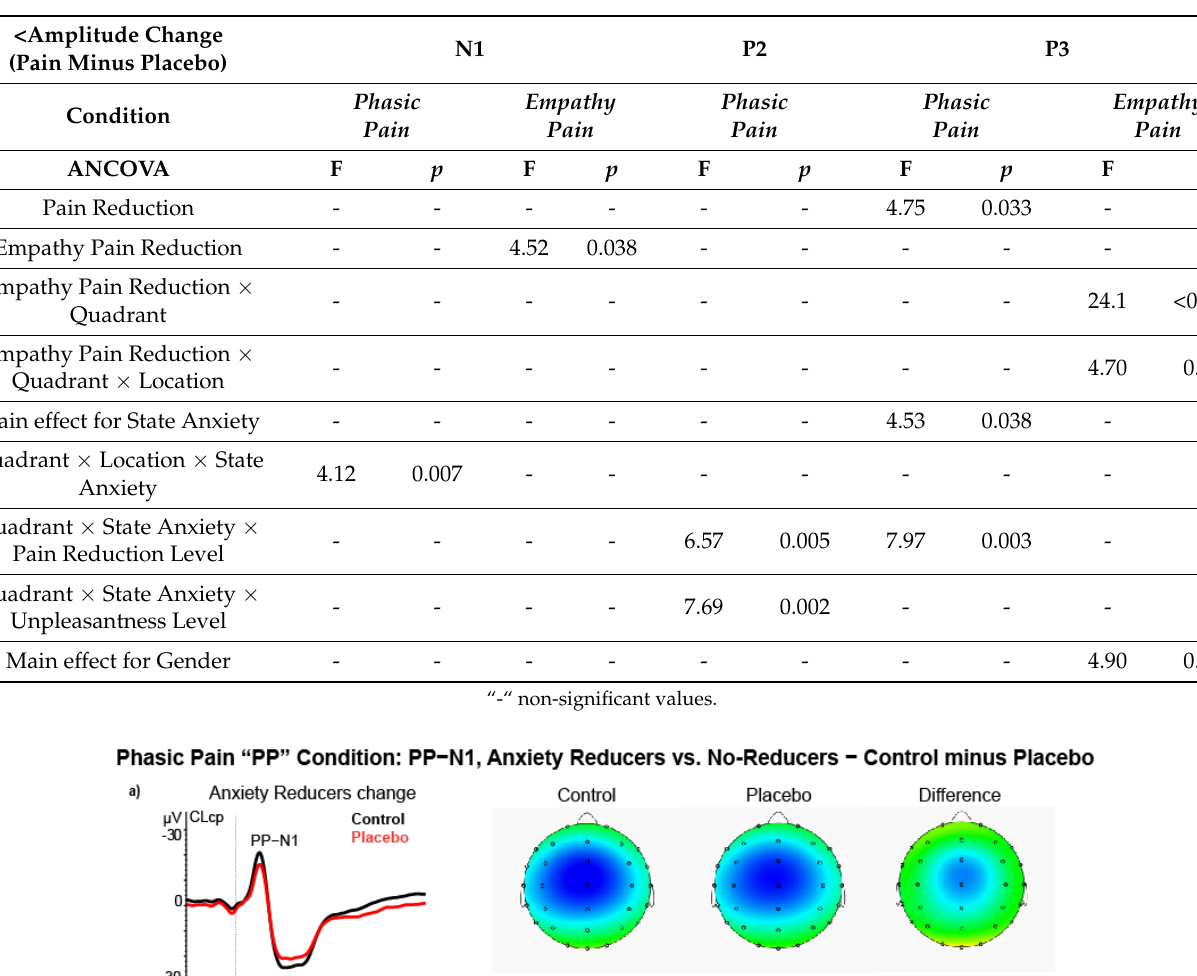
Table 2. Significant effects detected by ANCOVA (Gender and State Anxiety were entered as covariates).